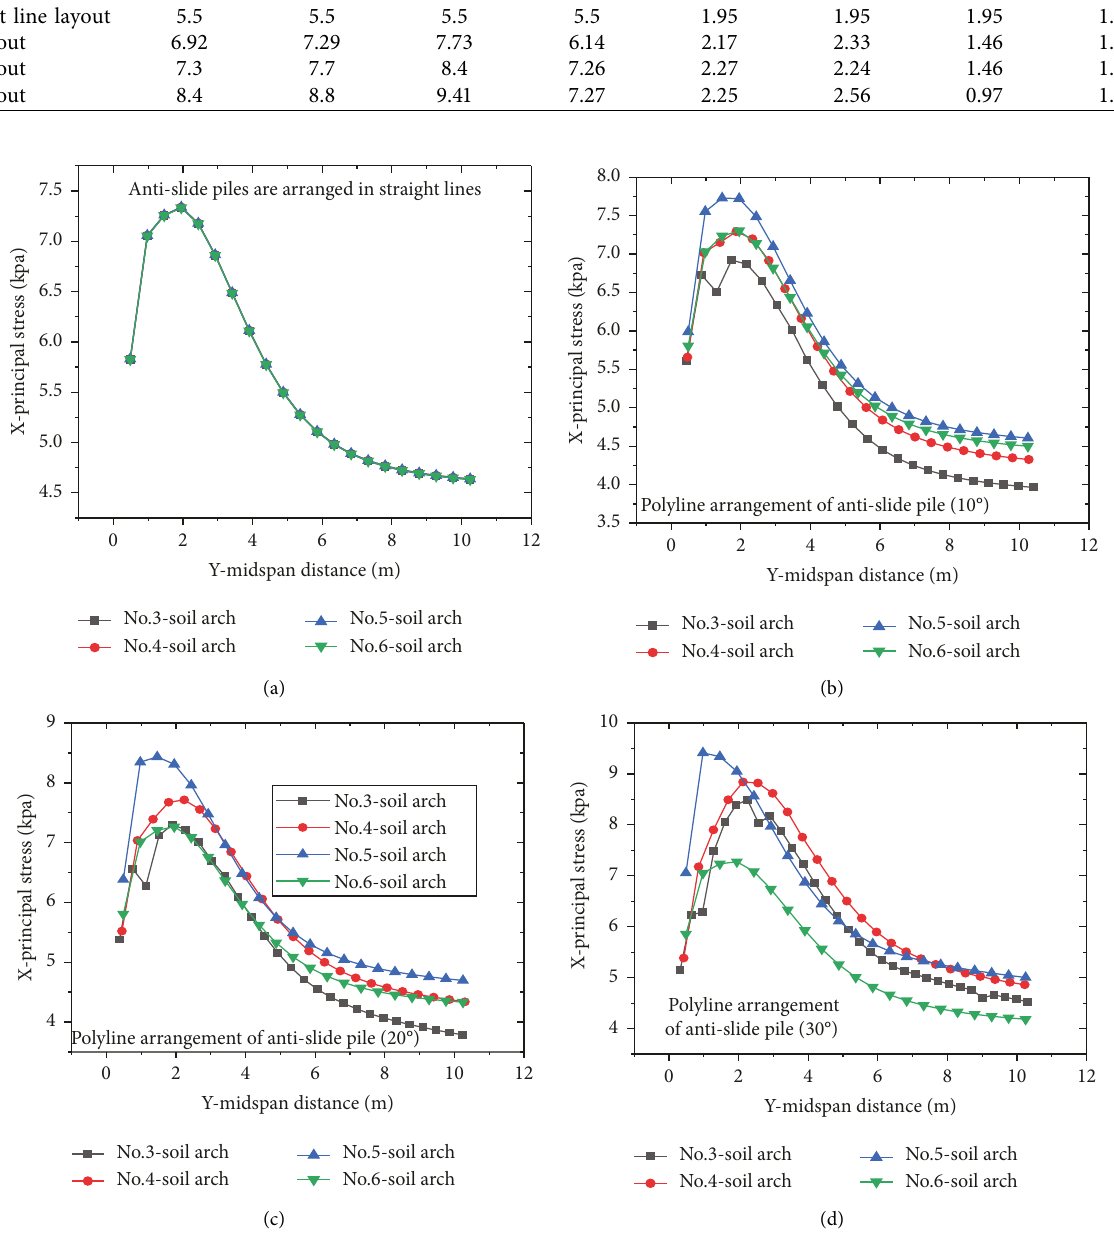
Figure 13: Comparisons among principal stress curves in the X